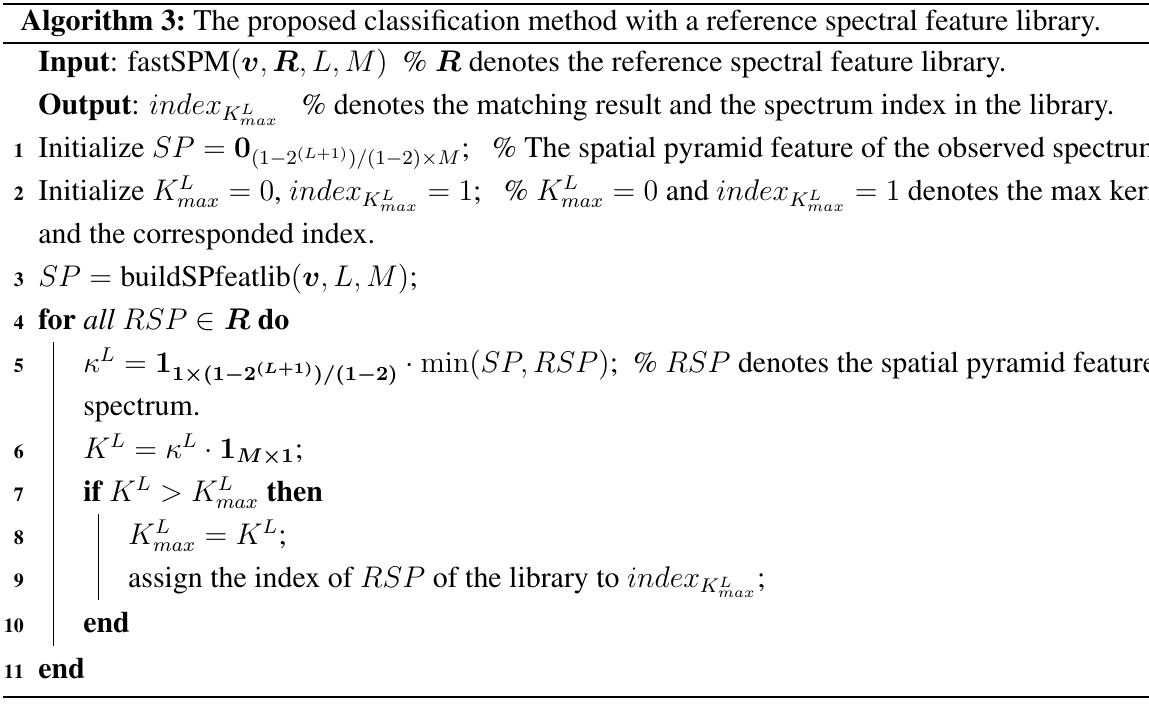
Algorithm 3: The proposed classification method with a reference spectral feature